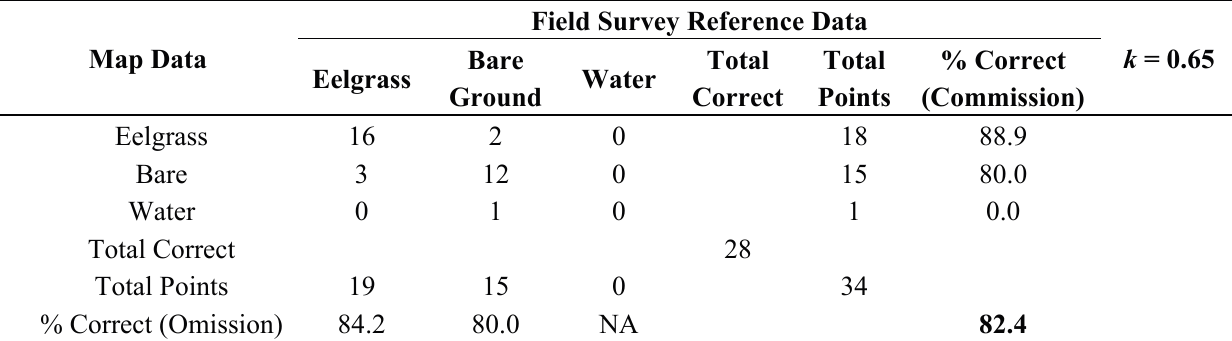
Table A9. Final product for classification of habitats in Middle